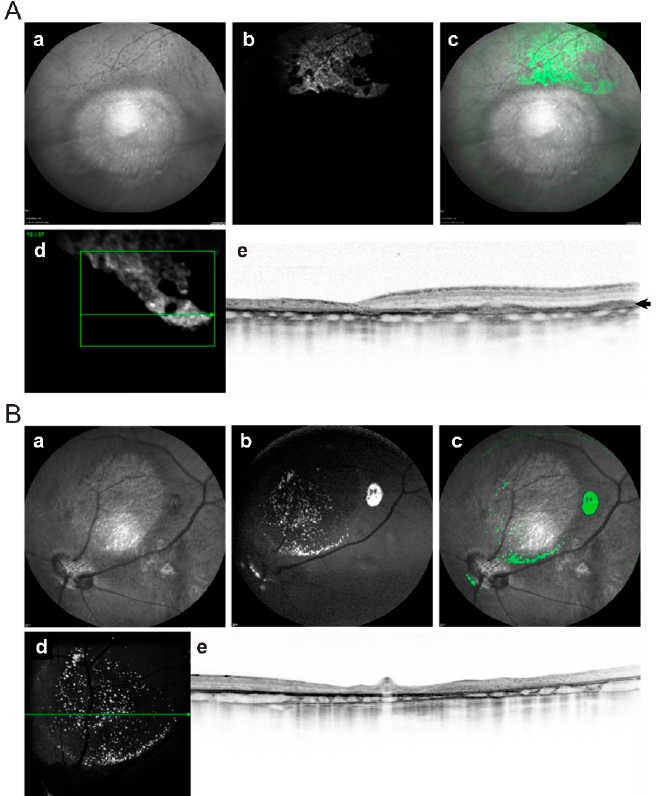
Figure 4. Multimodal fundus imaging showing the presence of hiPSC-RPE cells in healthy ( A ) and atrophic ( B ) retina in pigs 9 and 7 respectively, at 3 months post-injection. Well-demarcated round areas by IR fundus (a) four months after NaIO 3 subretinal injection. FAF (b) showing hyper-autofluorescence generated by the GFP expression in subretinal in- jected hiPSC-RPE cells . Pseudo-colored images (c) from increased autofluorescence in FAF imaging using Fiji show wide- spread ( A , c,d) and localized ( B , c,d) hiPSC-RPE cells (in green) outside the atrophic area, but also inside the atrophy region ( B , d). On FAF-guided SD-OCT, a well-organized RPE monolayer appears between native RPE and photoreceptors ( A , e) as a new hyper-reflective layer of hiPSC-RPE cells in healthy retina. A granular distribution of the hiPSC-RPE cells (hyper-reflective dots) is shown in the outer retinal layers of the atrophic retina ( B , e). Green squares delineate scan area and green horizontal line show scan directions and level. FAF, fundus autofluorescence; GFP, green fluorescence protein; NaIO 3 , sodium iodate; SD-OCT, spectral-domain optic coherence tomography; RPE, retinal pigment epithelium. 2.4. Post-Mortem Analysis of Retinas Transplanted with hiPSC-RPE Cells Animal 1 was euthanized at 6 months, animal 2 died and was analyzed at 2 weeks, and the remaining animals were euthanized at 3 months (Table 1). Surviving hiPSC-RPE cells were found engrafted in areas of healthy retina in 5 animals (1, 2, 5, 6, and 9), and at the margins of the atrophy and/or within the atrophied retina in 4 animals (1, 2, 7, and 9) (Table 1). Post-mortem analysis of animal 2 at 2 weeks following transplantation revealed hy- per-autofluorescence corresponding to engrafted hiPSC-RPE cells in an area covering the healthy retina, the limiting border, and a small part of the atrophy area (Figure 5A, circle denotes the atrophic zone, and Figure 5B). Within the healthy retina, GFP-positive cells exhibited an elongated cell morphology, interacted with POS (recoverin and rhodopsin), and expressed the human nuclear antigens Ku80 and bestrophin-1. We also found isolated GFP+ cells within the atrophied area (Figure 5D).